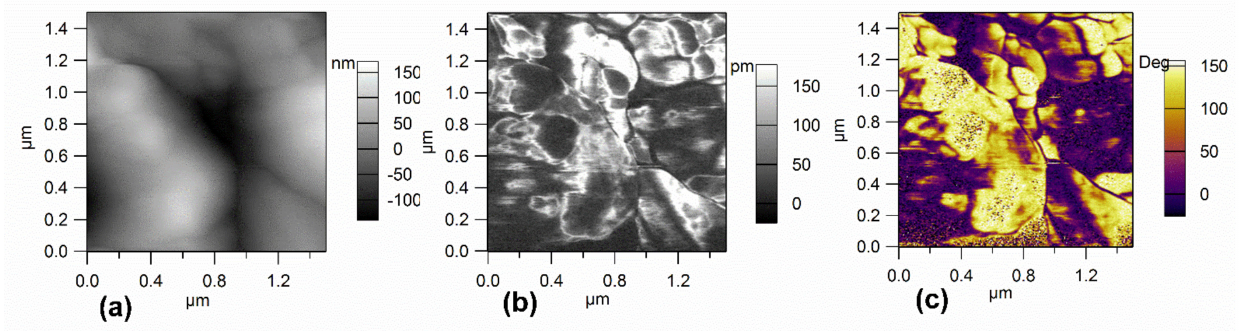
Figure 3. MAPI crystal: ( a ) AFM topography, ( b ) piezoresponse amplitude, and ( c ) piezoresponse phase.